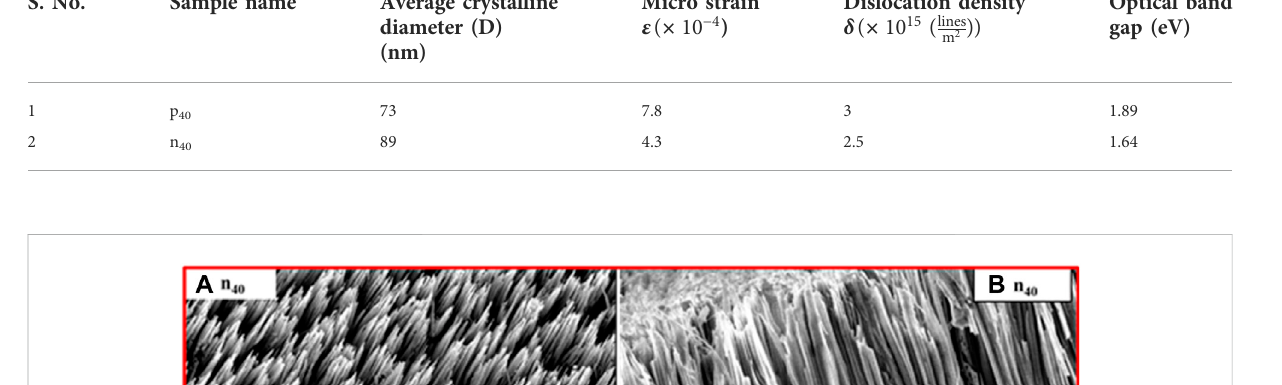
TABLE 1 Summarized microstructural and elastic parameters of the Si NWs. S. No.